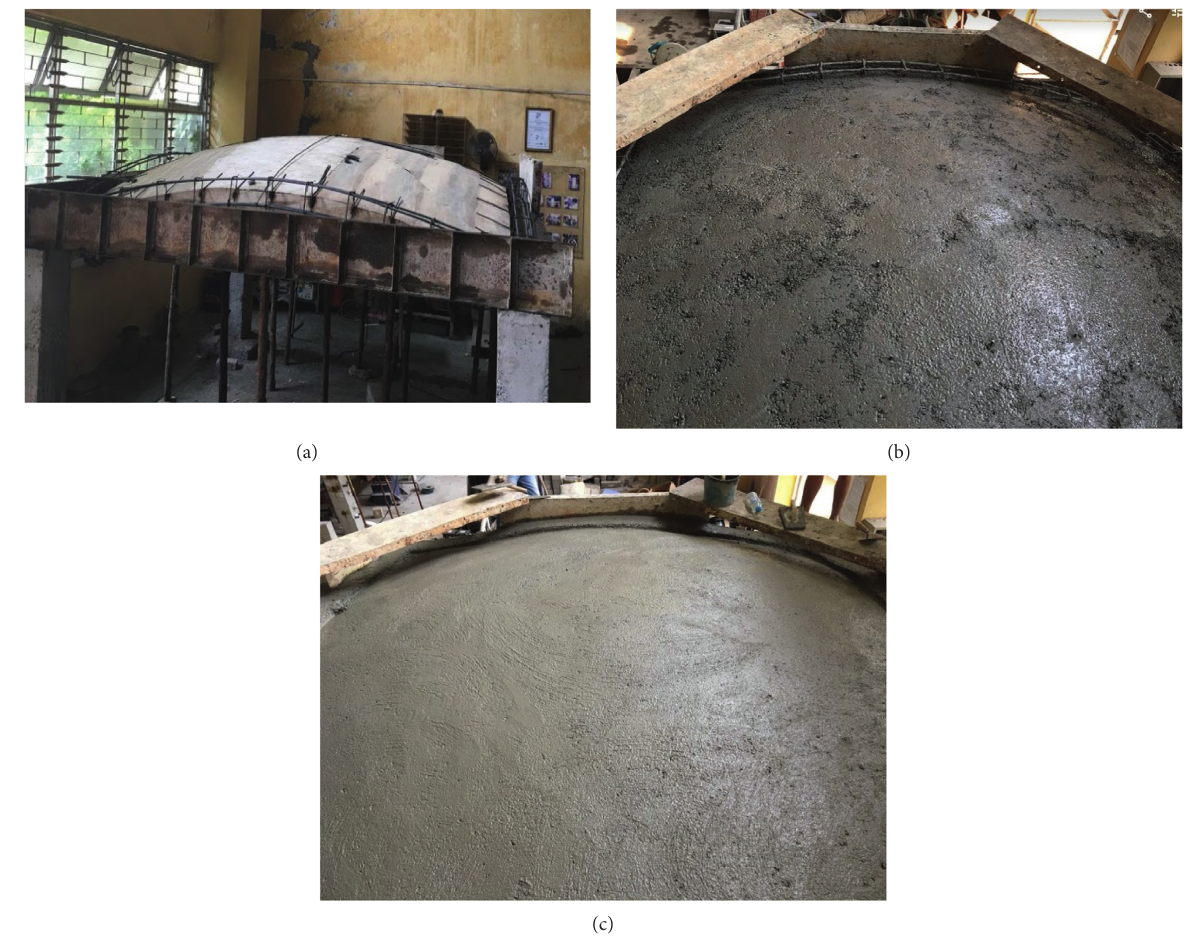
Figure 2: Making the formwork and pouring concrete layers: (a) make the formwork, (b) the first layer of steel fibres concrete was poured, and (c) the normal concrete layer is poured